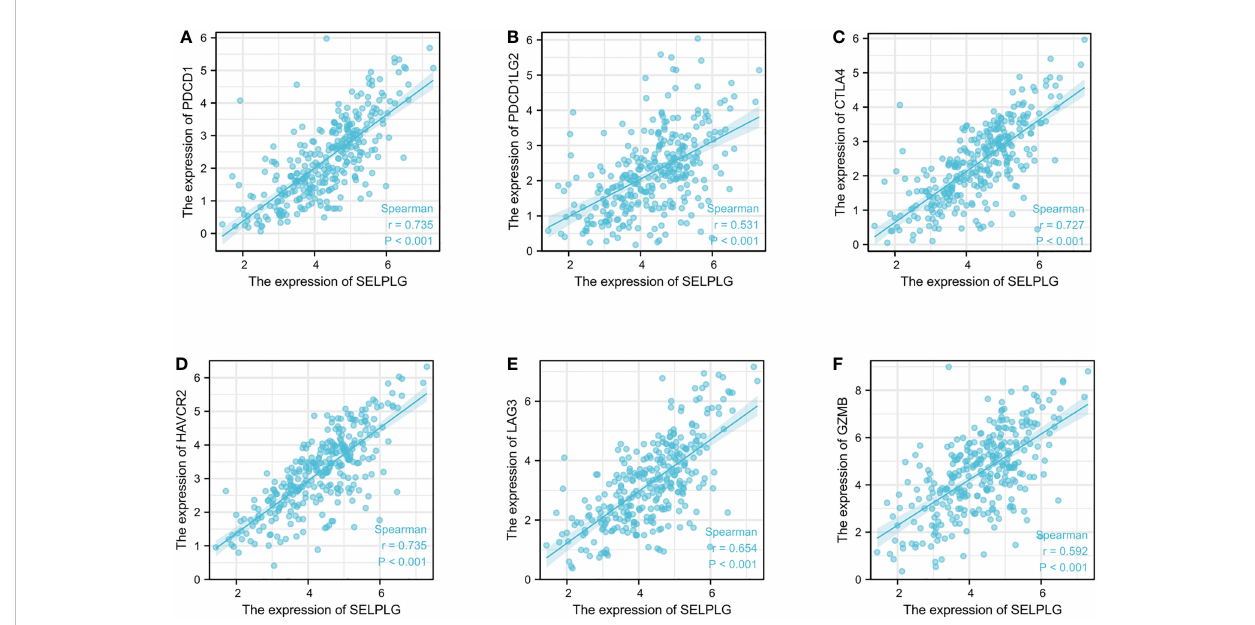
FIGURE 5 PSGL-1 expression correlated with immunoinhibitors in cervical cancer. (A – F) : PDCD1, PDCD1LG2, CTLA4, HAVCR2, LAG3, and GZMB in cervical cancer is available in the TISIDB